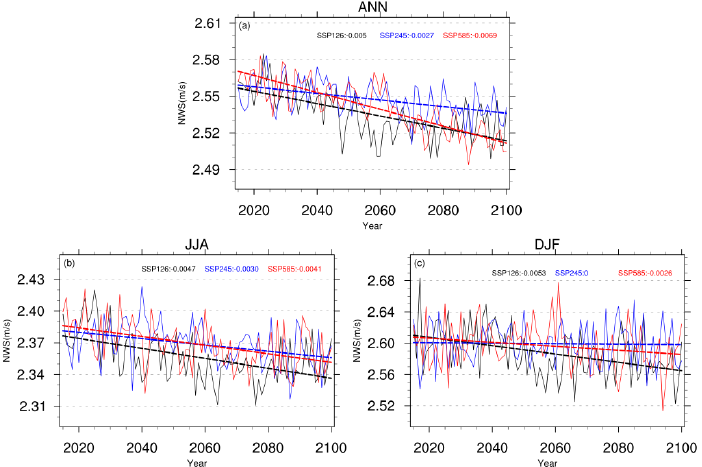
Figure 9. Time series of nationally averaged ( a ) annual, ( b ) summer, and ( c ) winter NWS over China under SSP1 - 2.6 (black line), SSP2 - 4.5 (blue line), and SSP5 - 8.5 (red line), with the trends passing the 99% statistical significance test.